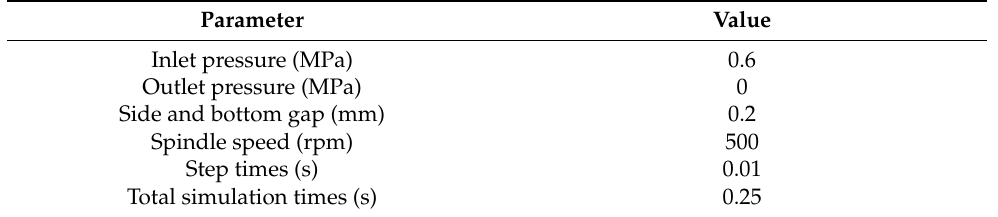
Figure 3. Geometric model of flow field simulation. Table 1. Flow field simulation